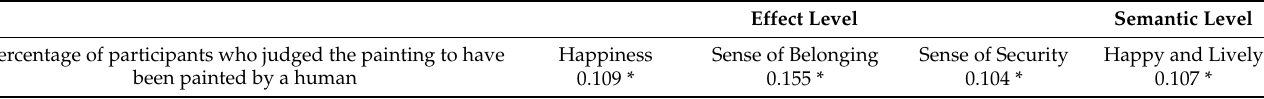
Table 2. Participants’ judgments on the effect level and semantic